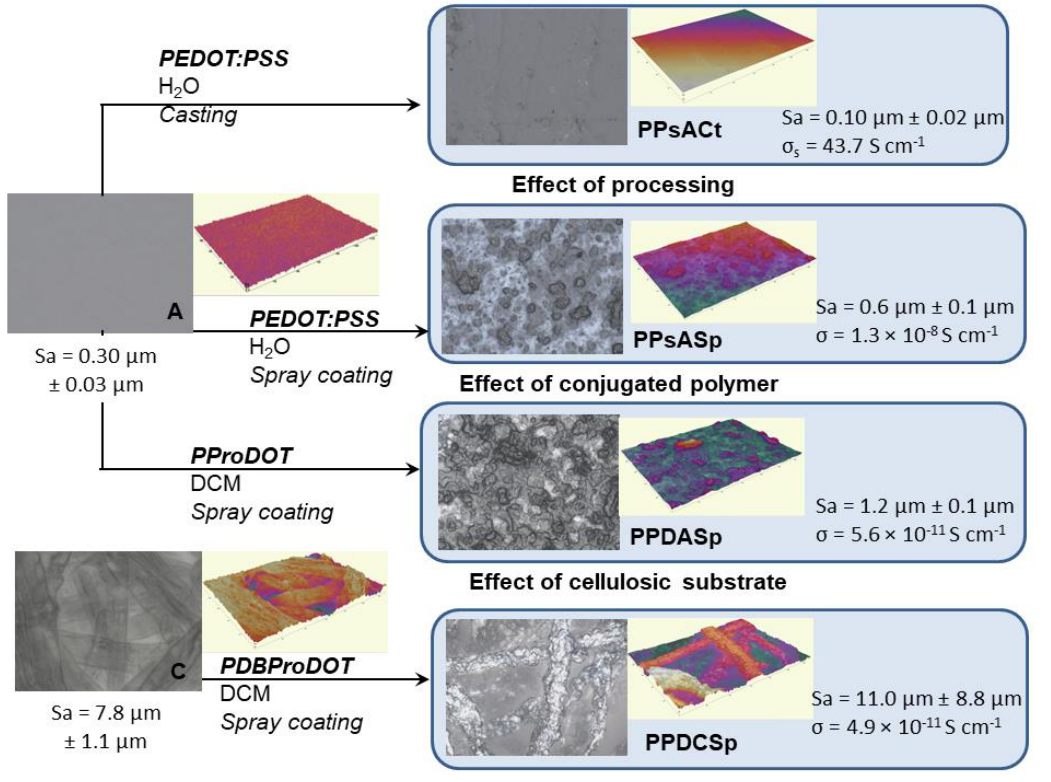
Table 4. Surface conductivities, polymer content, mass loading and roughness values for in-situ prepared composite materials.